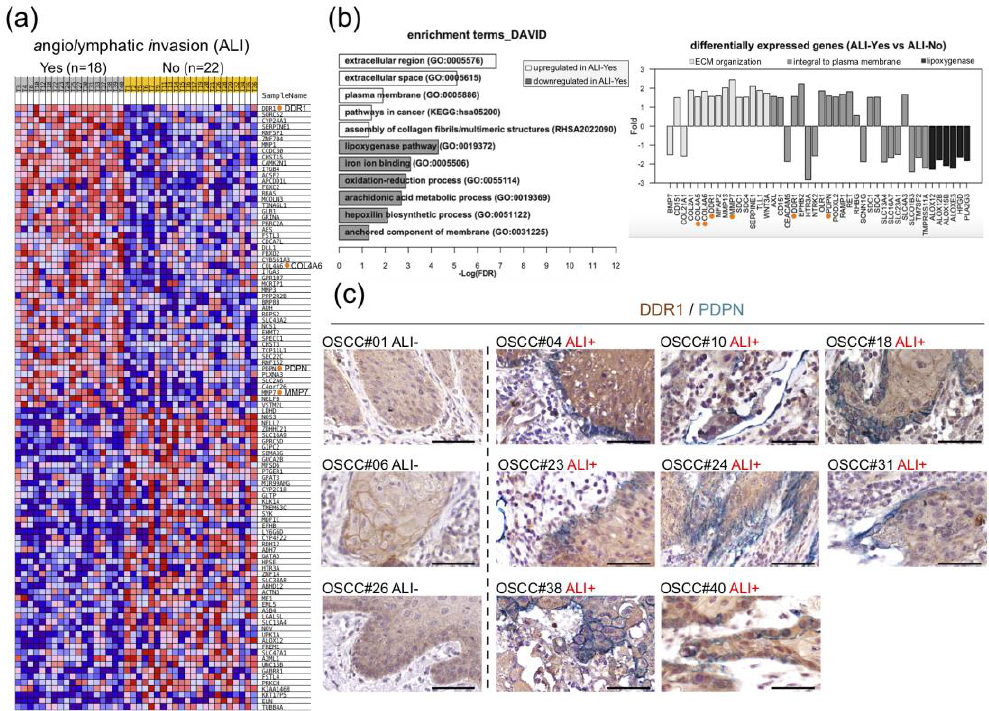
Figure 1. Upregulation of DDR1 and co-localization of DDR1 and PDPN in the invasion front of OSCC tissues with angiolymphatic invasion (ALI). ( a ) Heat map shows top 100 genes di ff erentially expressed in ALI-Yes ( n = 18) and ALI-No ( n = 22). Expression values of high, moderate, low, and lowest are represented as red, pink, light blue, and dark blue, respectively [32]. DDR1, COL4A6, PDPN, and MMP7 are marked with orange dots. ( b ) Enriched gene ontology terms (left panel, FDR < 0.05) and selected di ff erentially expressed genes (right panel, fold change > 1.5) in ALI. COL4A5, COL4A6, DDR1, MMP7 and PDPN are denoted with orange dots. ( c ) Representative immunohistochemistry images of OSCC tissues stained for DDR1 (brown) and PDPN (green). Scale bars, 50 μm.